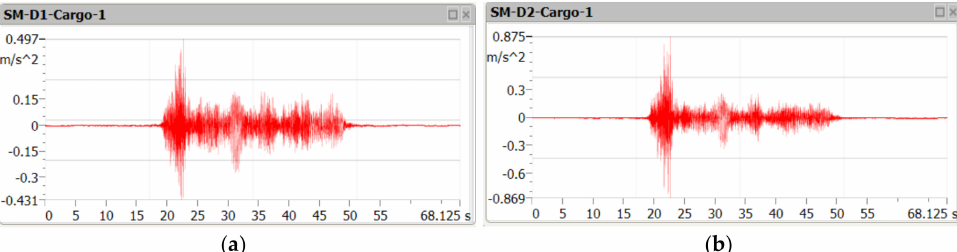
Figure 5. Amplitude of vertical vibration acceleration during the passage of the cargo train at the speed of 40 km/h, in the deck slab ( a ) and the bottom flange of the girder ( b ).